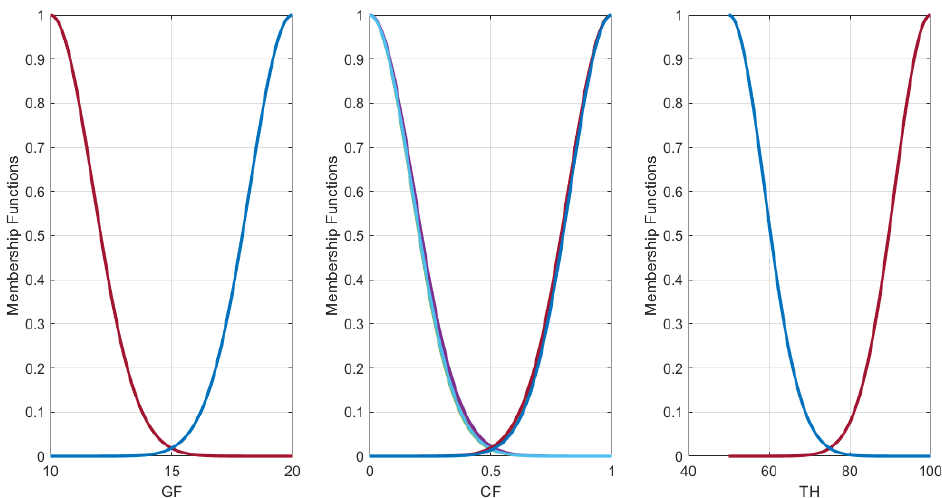
Figure 6. The ANFIS-based model inputs’ MFs.